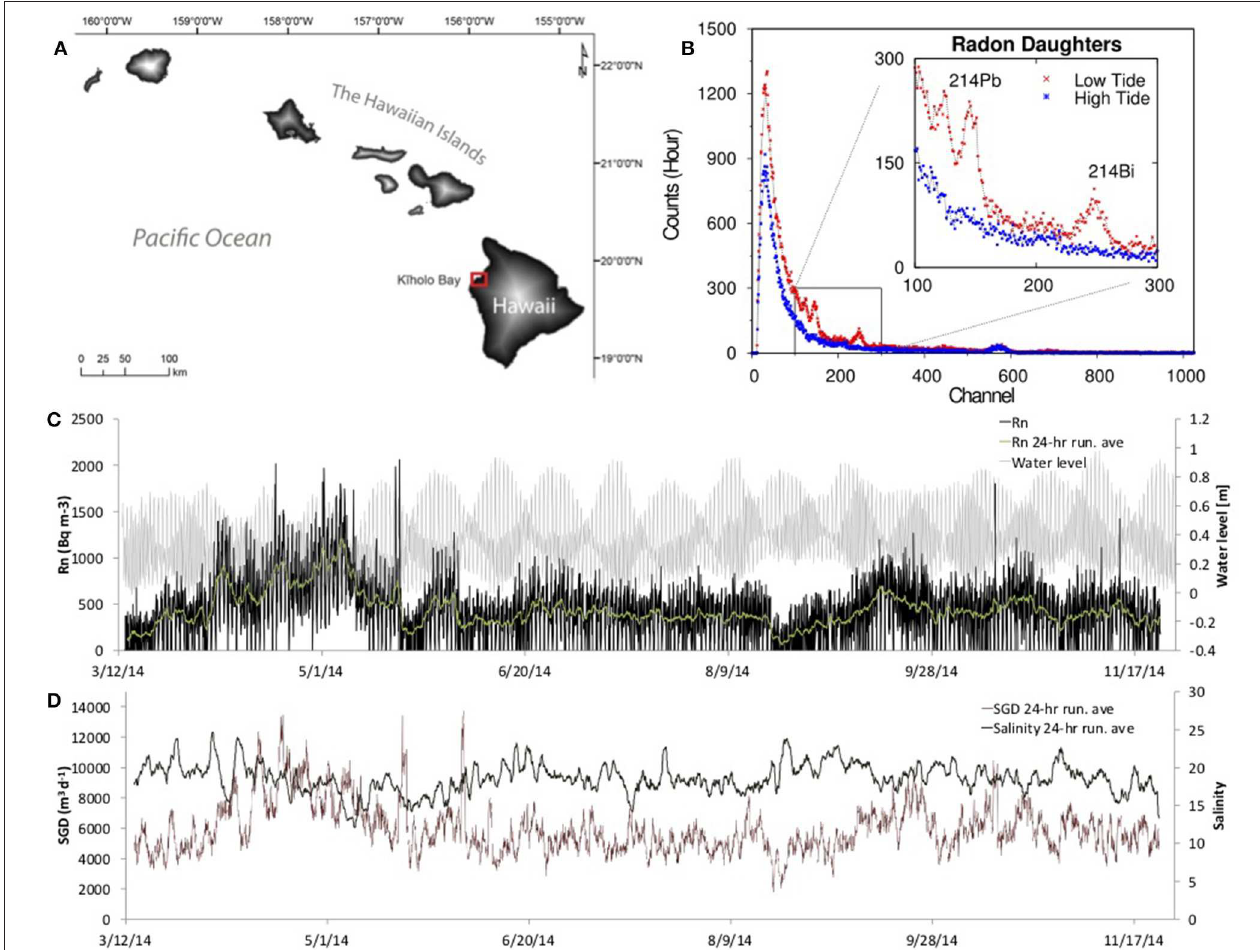
FIGURE 5 | (A) An autonomous gamma-spectrometer [NaI(Tl)] was deployed off the coast of Kiholo Bay, HI, USA. (B) Gamma-ray spectra were collected in the surface waters at hourly resolution. (C) The spectra during low tide show radon decay products, while at high tide radon and its progenies are diluted to below detection levels. (D) Hourly radon measurements over multiple years (a 9-month record shown here) allows us to evaluate SGD dynamics over tidal and seasonal time scales. Data from Dulai et al.